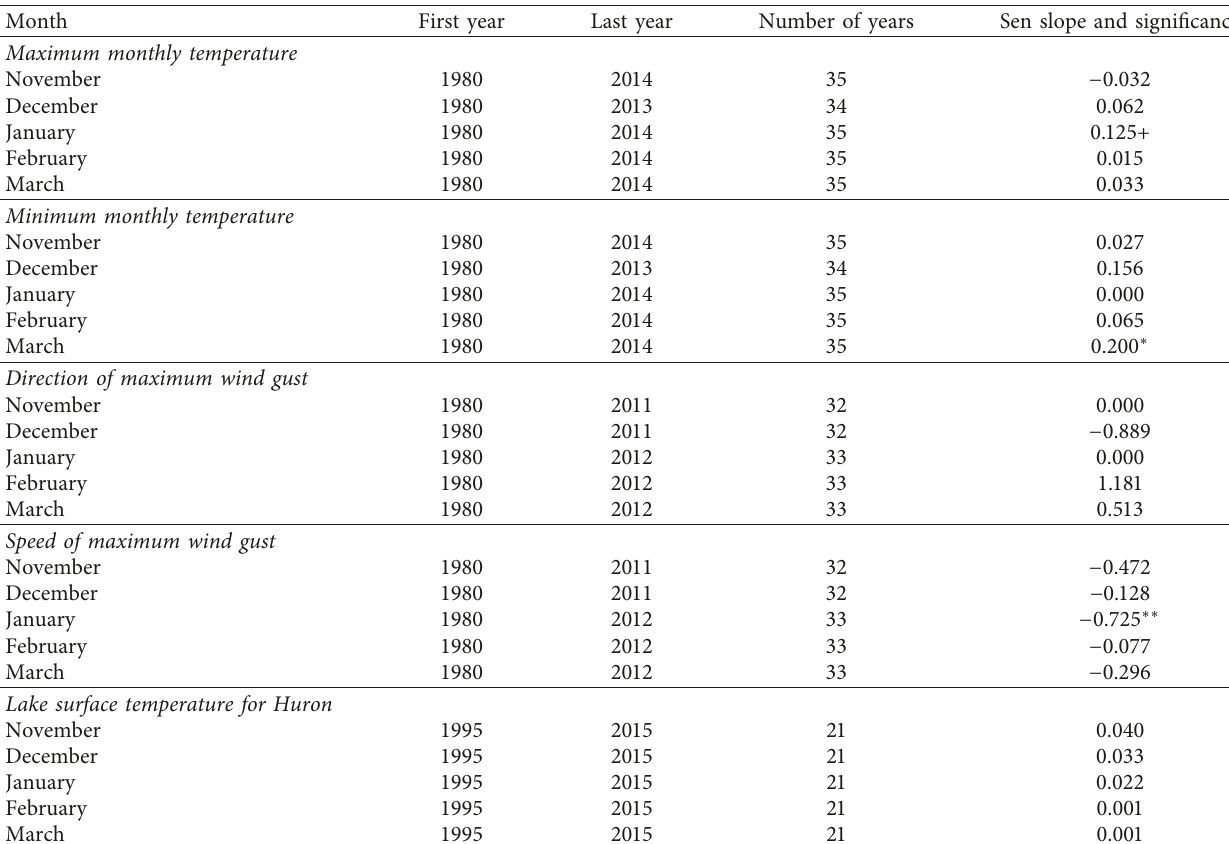
Table 4: Predictor variable trend analysis for each month of the cold season with corresponding years used in Sen slope calculation for Wiarton, Ontario.